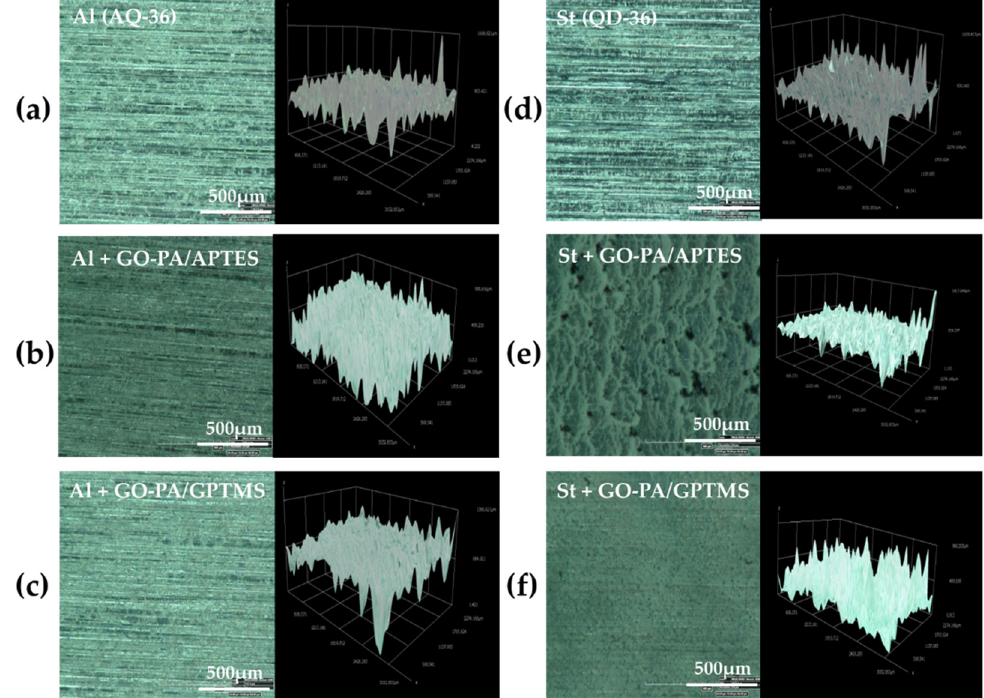
Figure 10. Optical microscopy images of GO-PA/APTES ( b , e ) and GO-PA/GPTMS ( c , f ) coatings deposited on the aluminum ( a ) and steel ( d ) standard panels, with 3D images of the roughness of the analyzed samples.